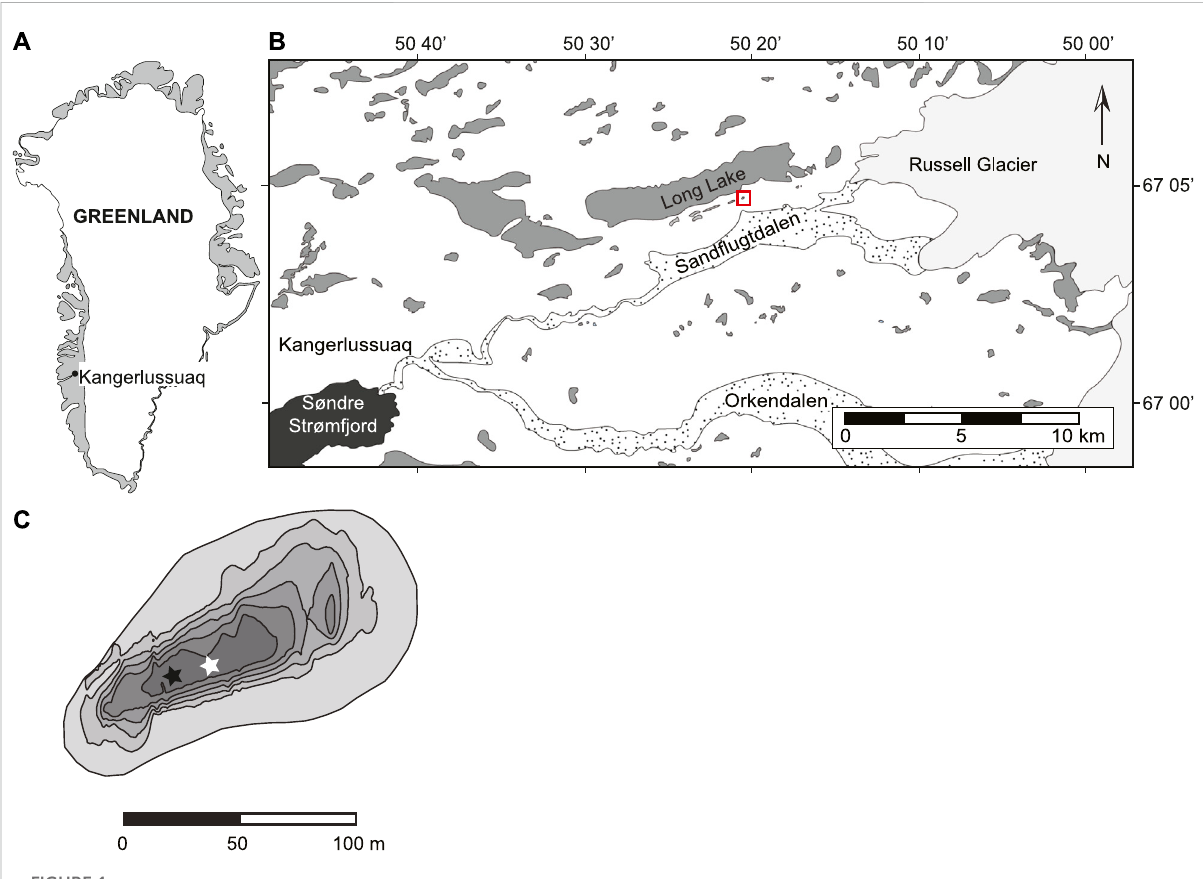
FIGURE 1 Figure 1: Maps of (A) Greenland showing Kangerlussuaq; (B) zoom in of Kangerlussuaq region. Red box highlights Teardrop lake; (C) Teardrop lake bathymetry (contour interval = 1 m) showing sample locations. White star shows East sampling location (discussed in paper); black star shows West sampling location. Modifed from Cadieux et al.,